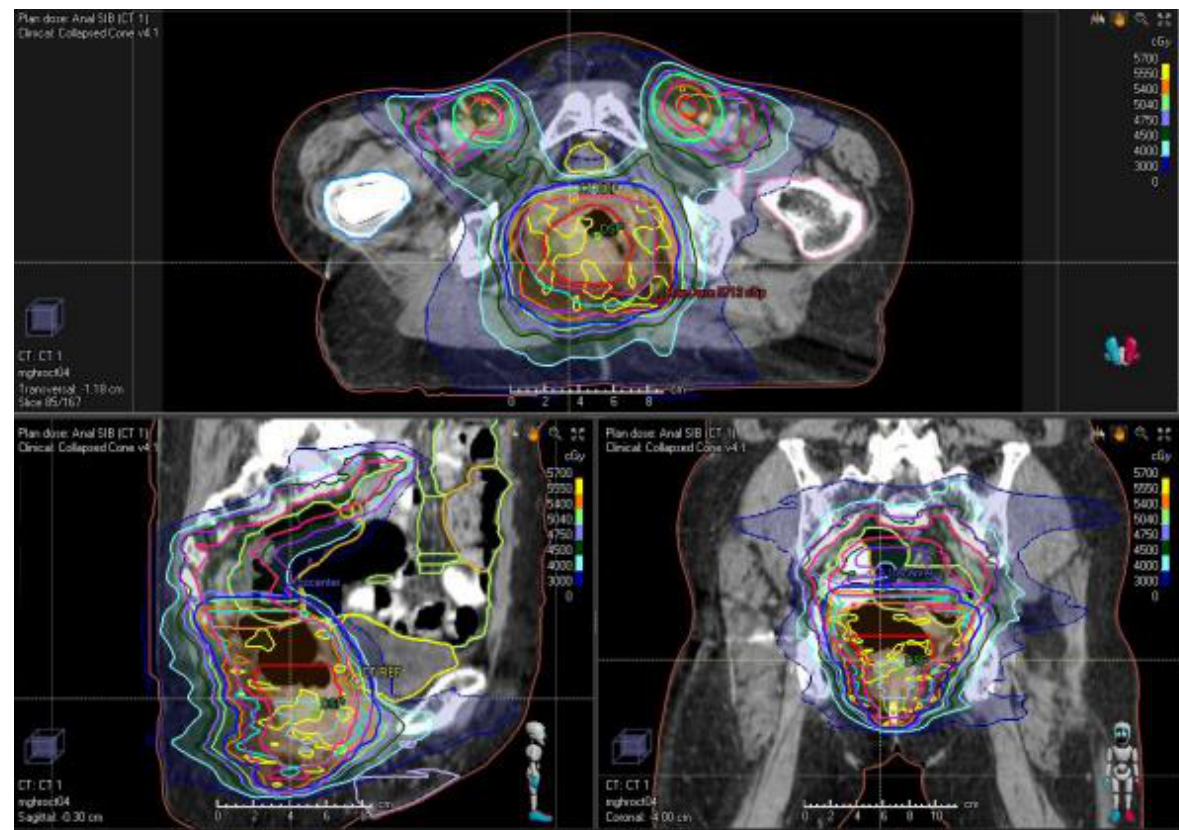
Figure 2. Example of VMAT photon plan for a patient with clinically staged T2N1 anal cancer. The primary tumor and mesorectum, involved lymph node, and elective nodes were treated to 54 Gy, 50.4 Gy, and 45 Gy in 30 fractions, respectively.